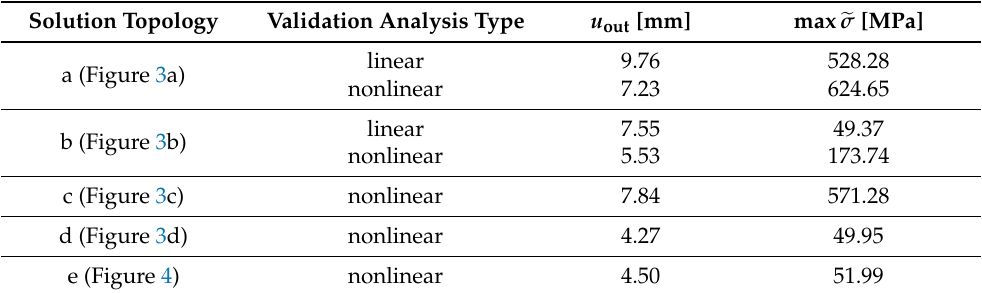
Table 3. Output displacement and maximum stress values for the gripper mechanism topologies in Figures 3 and